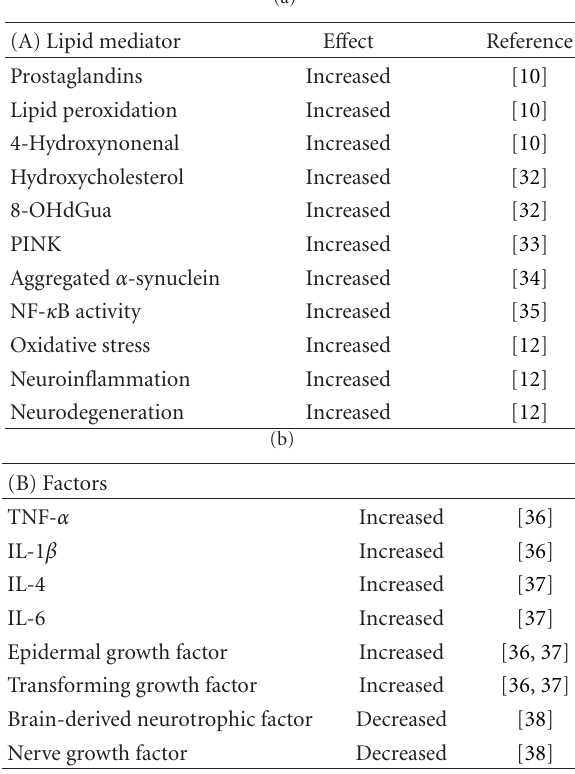
Table 1: Levels of mediators, proteins, and factors, which facilitate and maintain oxidative stress and inflammatory responses in